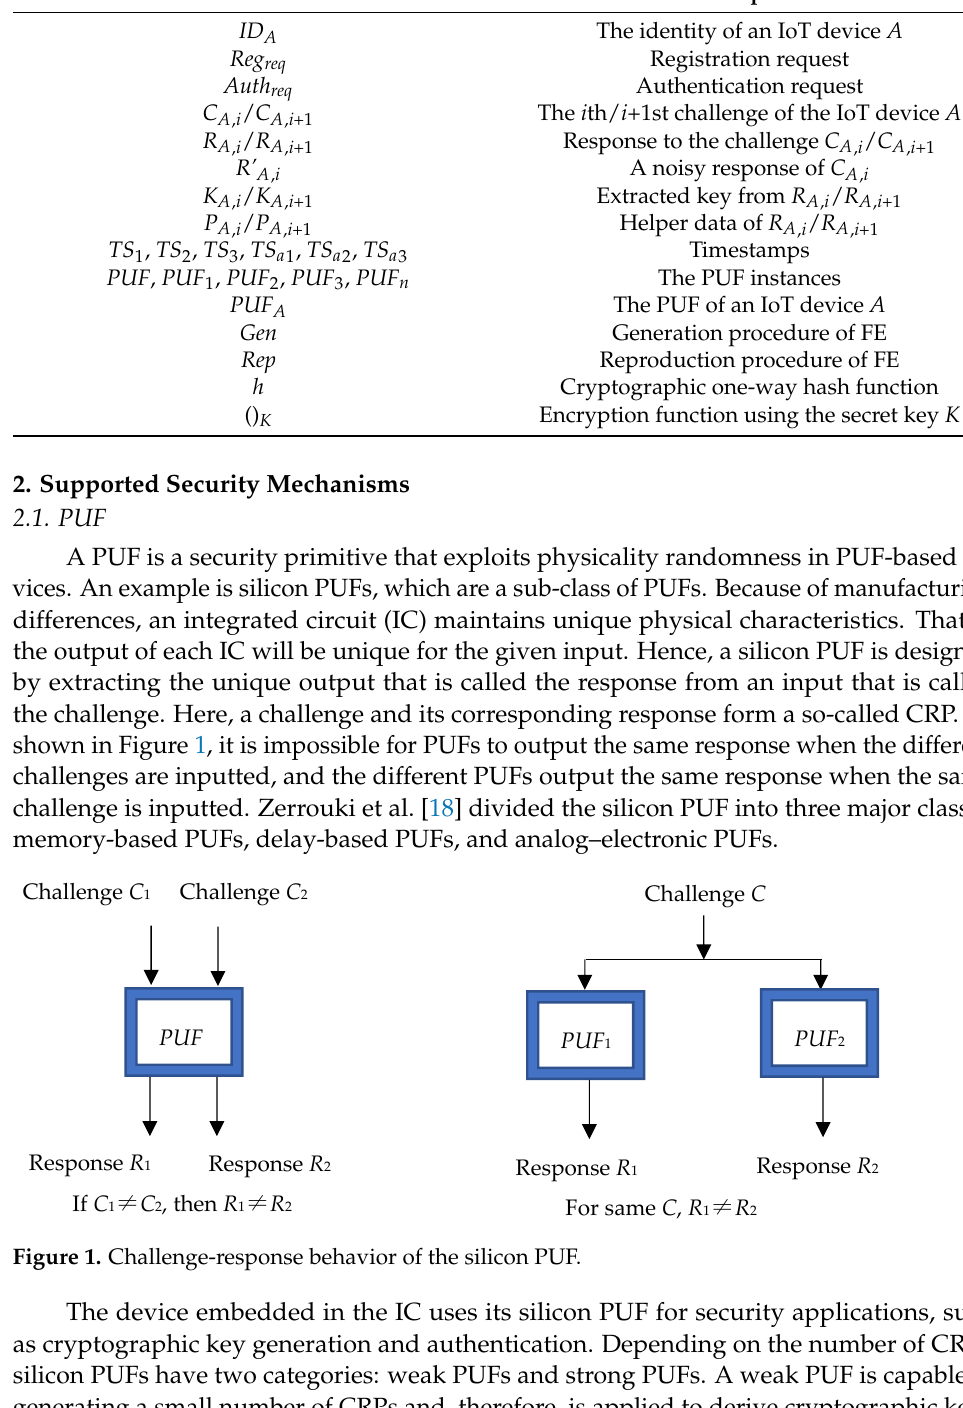
Table 1. Used Notation.